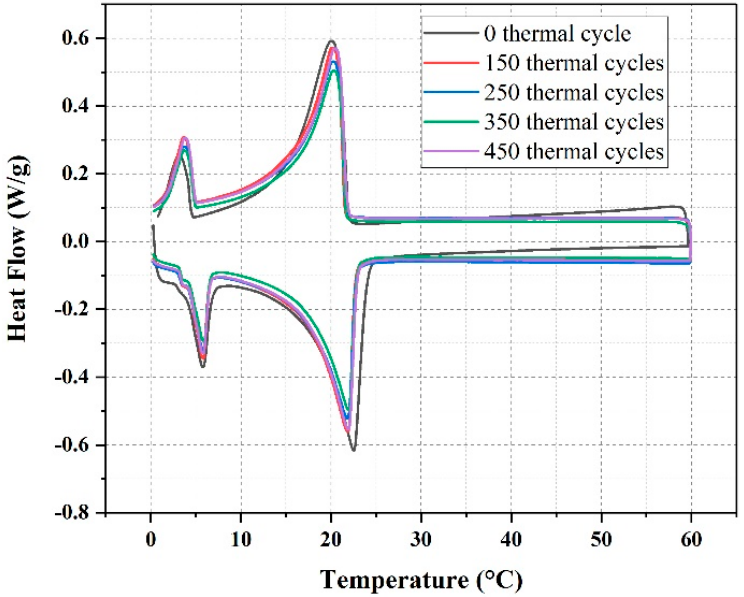
Figure 7. DSC curves of expanded graphite/paraffin under different thermal cycles. Table 2. The thermal properties of expanded graphite/paraffin under different thermal cycles. Melting Cycles